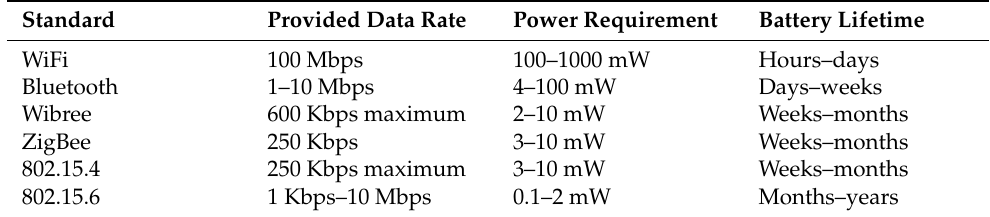
Table 6. Comparison of WBASN standards with other wireless standards